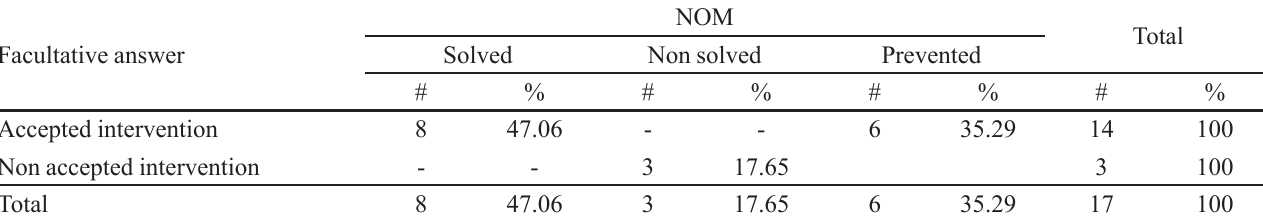
TABLE III - Physician´s answer to the pharmacist suggestions in order to solve or prevent the NOM and their solution